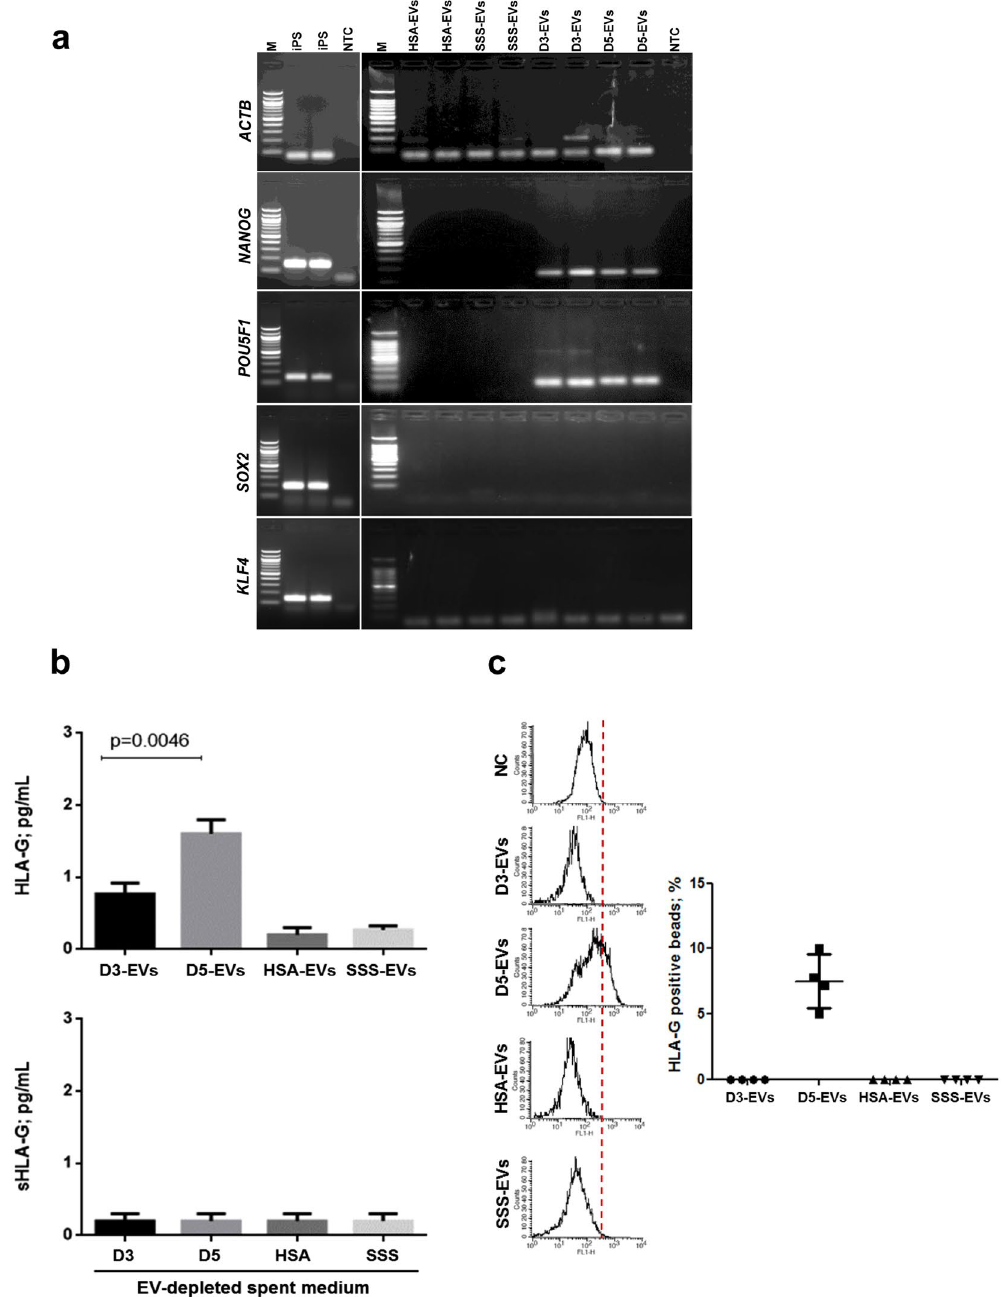
Figure 3. EVs isolated from day 3 and day 5 embryos contain embryonic specific molecules. ( a ) Five ng of EVs- derived amplified cDNA from a pool of spent media from 50 day 3 (D3-EVs) or day 5 (D5-EVs) embryos were subjected to touch down PCR in order to assess presence of pluripotency-related gene transcripts. Gel electrophoresis of PCR products is shown. iPS cDNA was used as a positive control and EVs derived from fresh media conditioned with 10% of SSS or 5% of HSA were used as negative controls (HSA-EVs and SSS-EVs). No template controls (NTC) were also added to distinguish the primer dimer formation. Three independent experiments have been performed and two different samples per condition are shown. M = 100 bp molecular ladder. ( b ) HLA-G levels in EVs (upper panel) from a pool of spent media of 50 embryos in day 3 (D3-EVs) or day 5 (D5-EVs) of development were evaluated by Bio-Plex assay. Equal volumes of fresh media conditioned with 10% of SSS (SSS-EVs or SSS) or 5% of HSA (HSA-EVs or HSA) were used as negative controls. Results are expressed as mean ± SEM, n = 6 (p < 0.0046, D5- EVs vs D3-EVs). Soluble HLA-G levels have been also evaluated in EV-depleted spent culture media from the same samples by Bio-Plex assay, n = 3 (lower panel). ( c ) Flow cytometry analysis was performed to confirm the levels of HLA-G in EVs. The same analysis was performed in both EVs and in transfected HeLa-G5 cell culture supernatants used as positive control (not shown) and in HeLa wild-type cell culture supernatants as negative control (NC). The samples were analyzed in duplicates. Results are expressed as mean ± SEM, n =